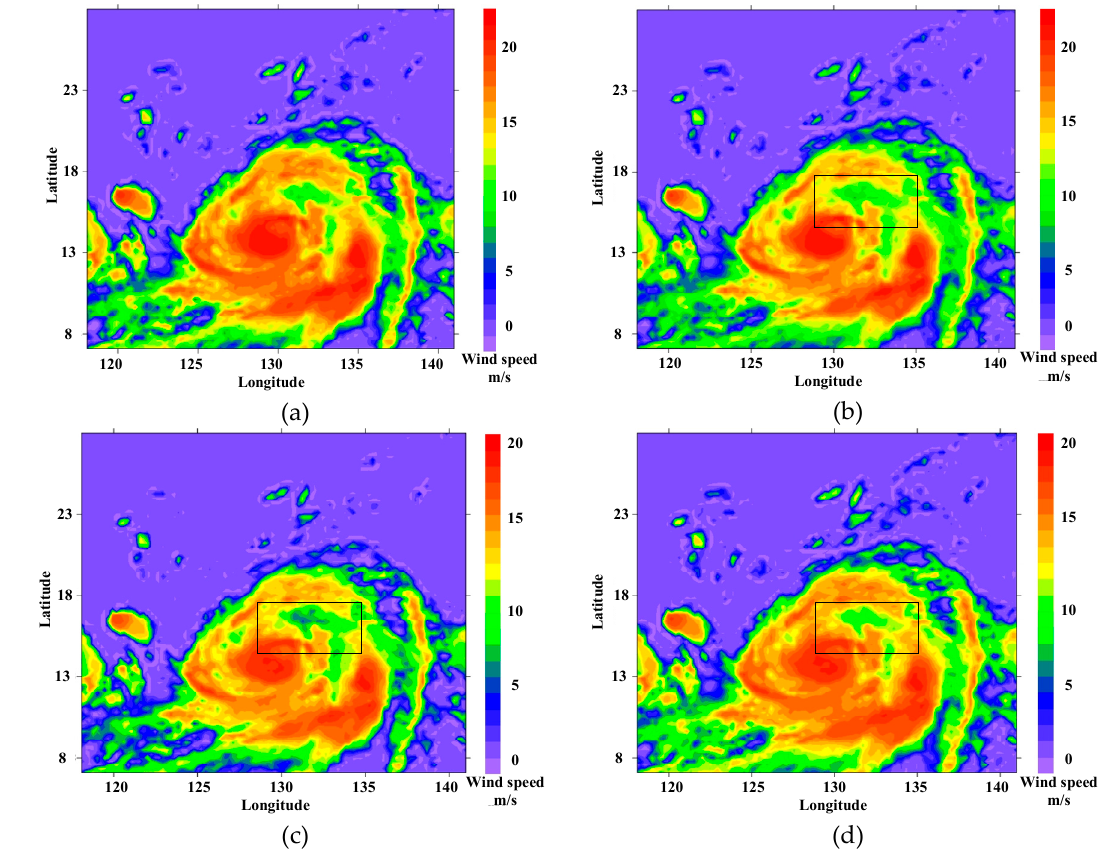
Figure 5. The sea surface wind field (SSWF) inversion maps by four regression models; the rectangular box represents the place where the inversion accuracy is low: ( a ) the linear model; ( b ) the exponential model; ( c ) the logarithmic model; ( d ) the power model.